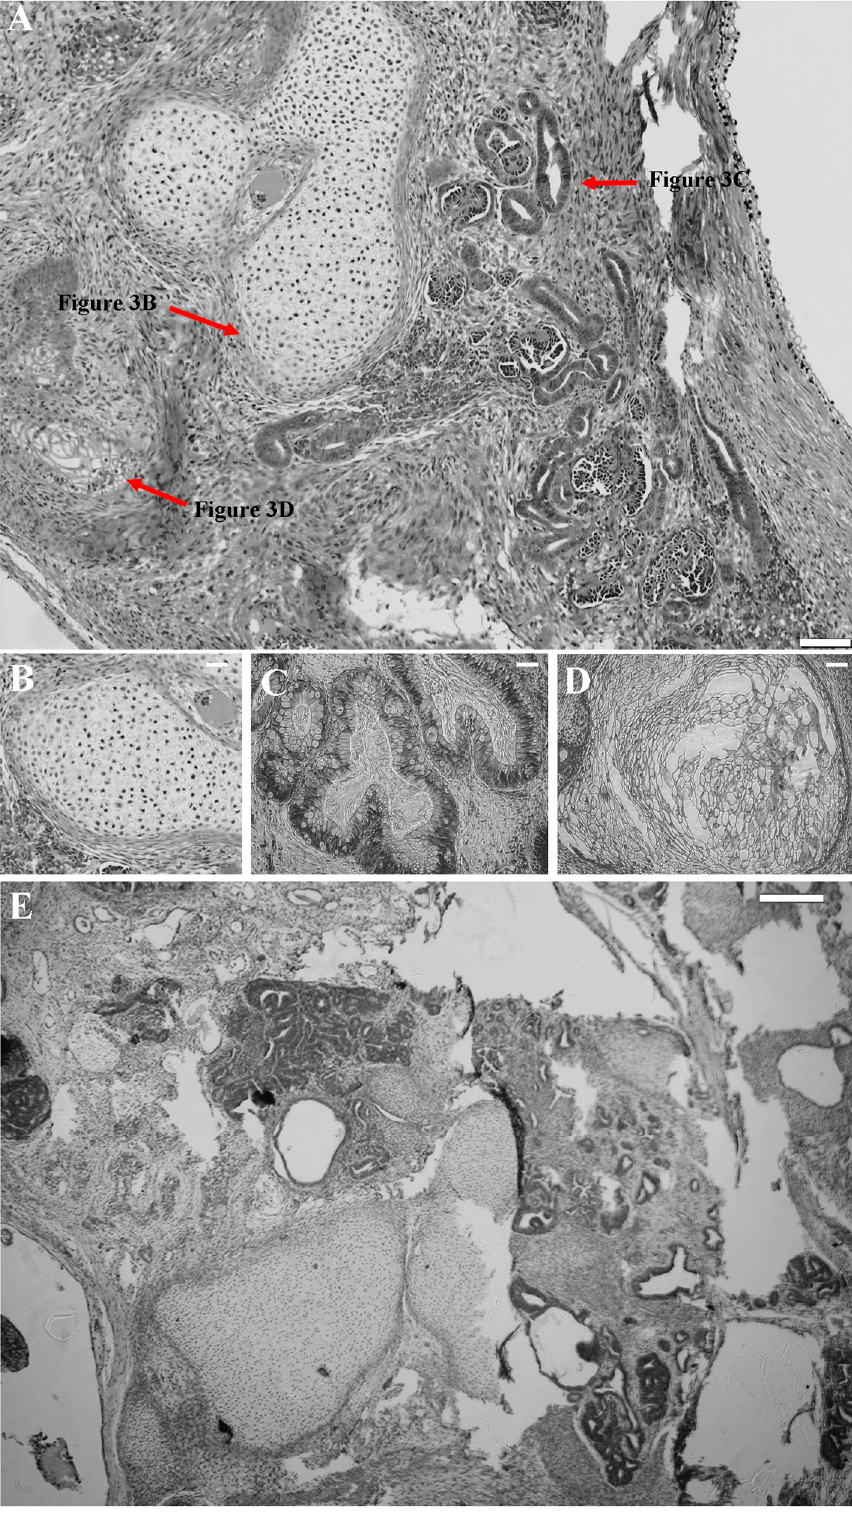
Figure 3. Reprogrammed kiPS cell lines generate teratomas in vivo. ( A ) Typical histopathologic images of kiPS-formed teratoma, containing three germ layer derivatives: ( B ) cartilage; ( C ) secreting epithelium; and ( D ) stratified epithelium; and ( E ) control histopathologic image of piPS-formed teratoma. ( A – D ) Magnification 100×, white bar represents 250 µm; and ( E ) magnification 40×, white bar represents 200 µm.